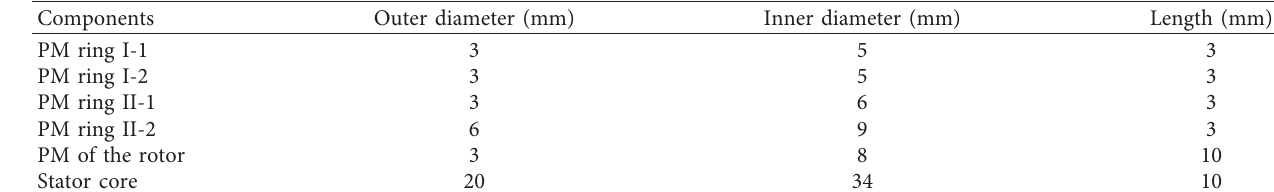
Table 1: Geometric parameters of magnetic bearings and the motor. Components